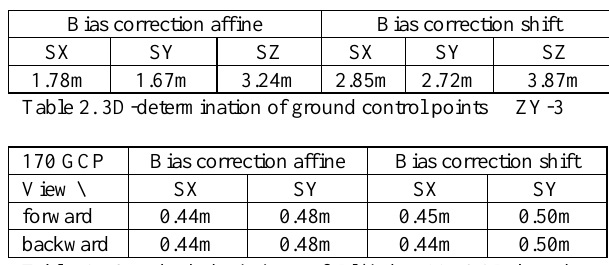
Table 3. Standard deviations of Pléiades 1A GCP based on RPC-image orientations improved by bias correction with affine transformation respectively shift; test area Zonguldak